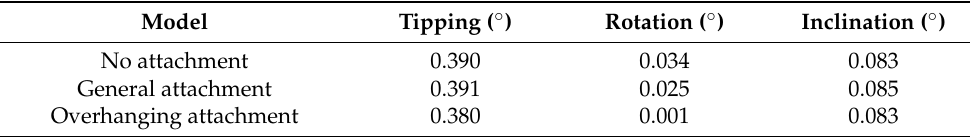
Table 3. Tooth movements measured for 0.75-mm-thick aligner